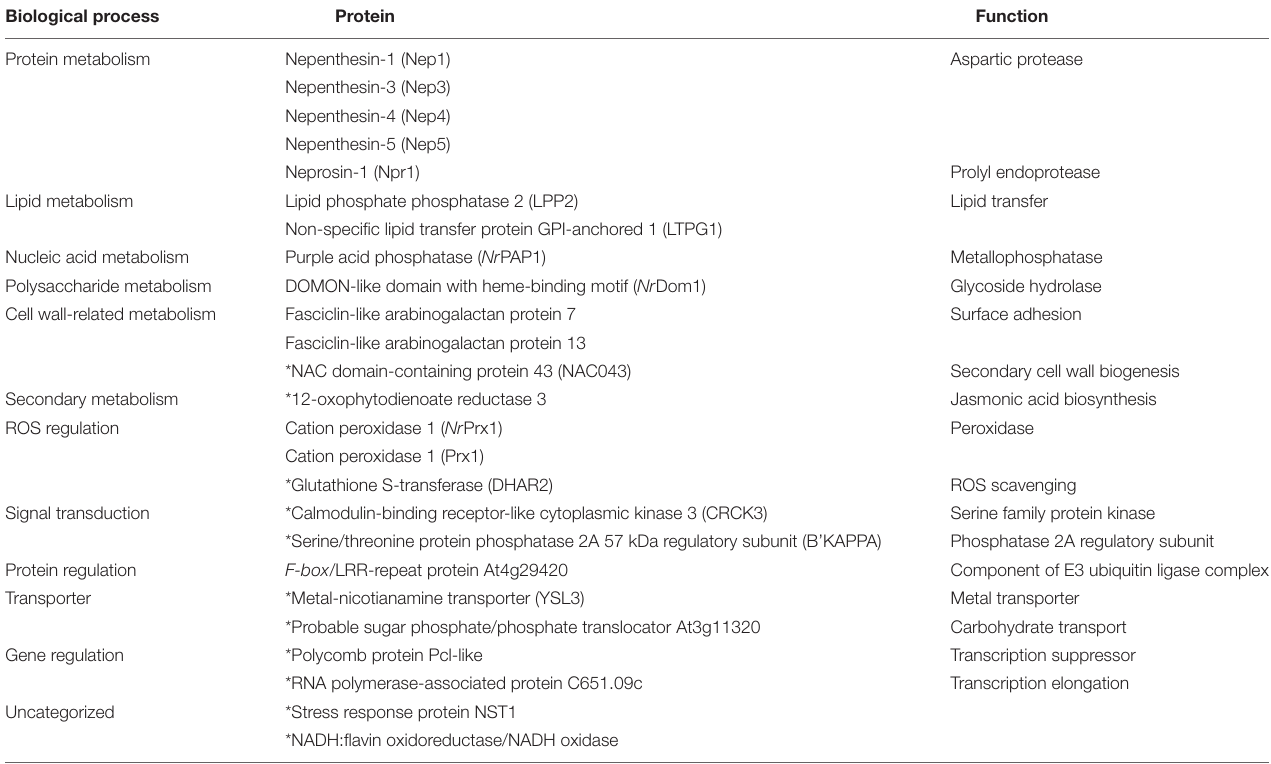
TABLE 2 | List of 25 identified pitcher fluid proteins shared by N. ampullaria , N. rafflesiana , and N. × hookeriana . Biological process Protein Function Protein